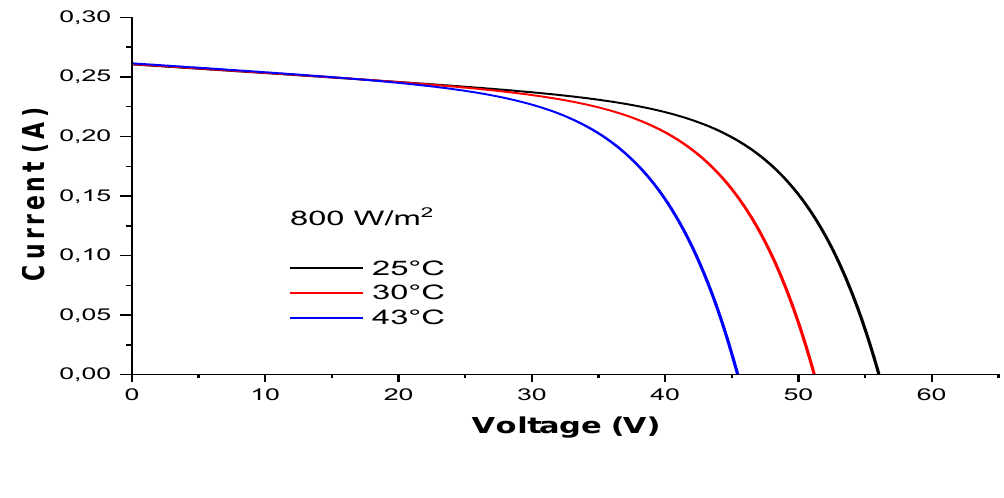
Figure 5. I-V curve showing the effect of temperature